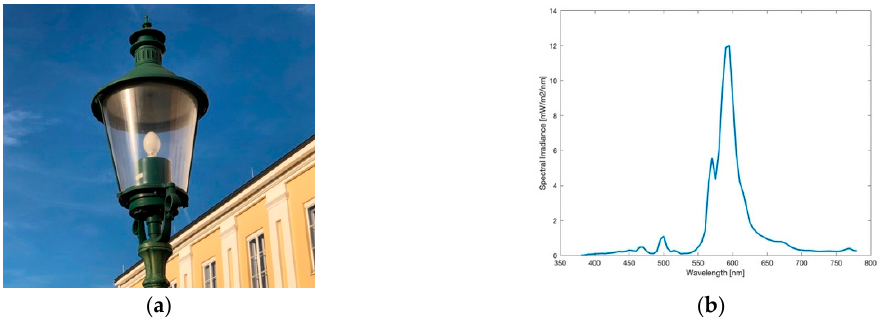
Figure 9. ( a ) Image of the lantern during daytime; ( b ) Spectrum of lamp observed.